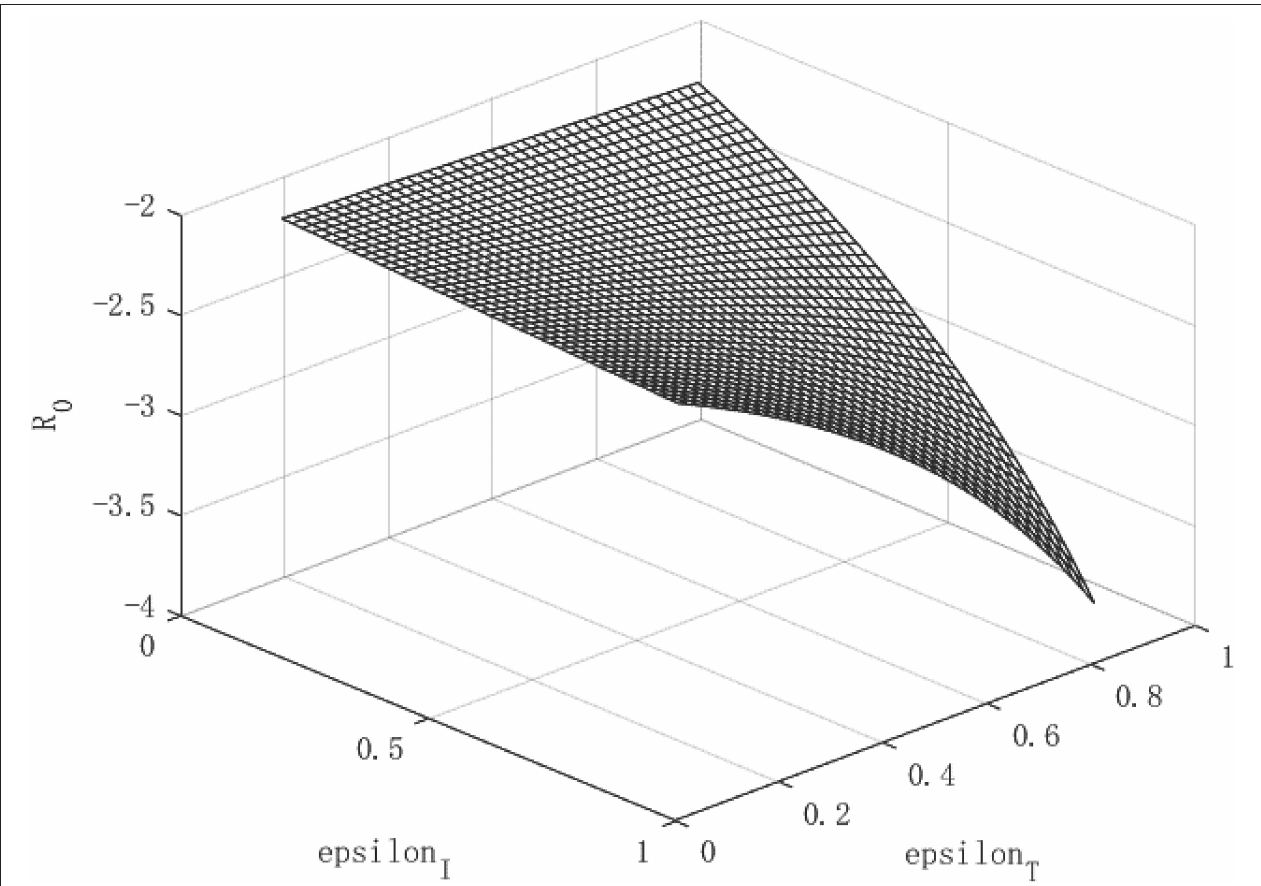
FIGURE 1 | Virus transmission path of